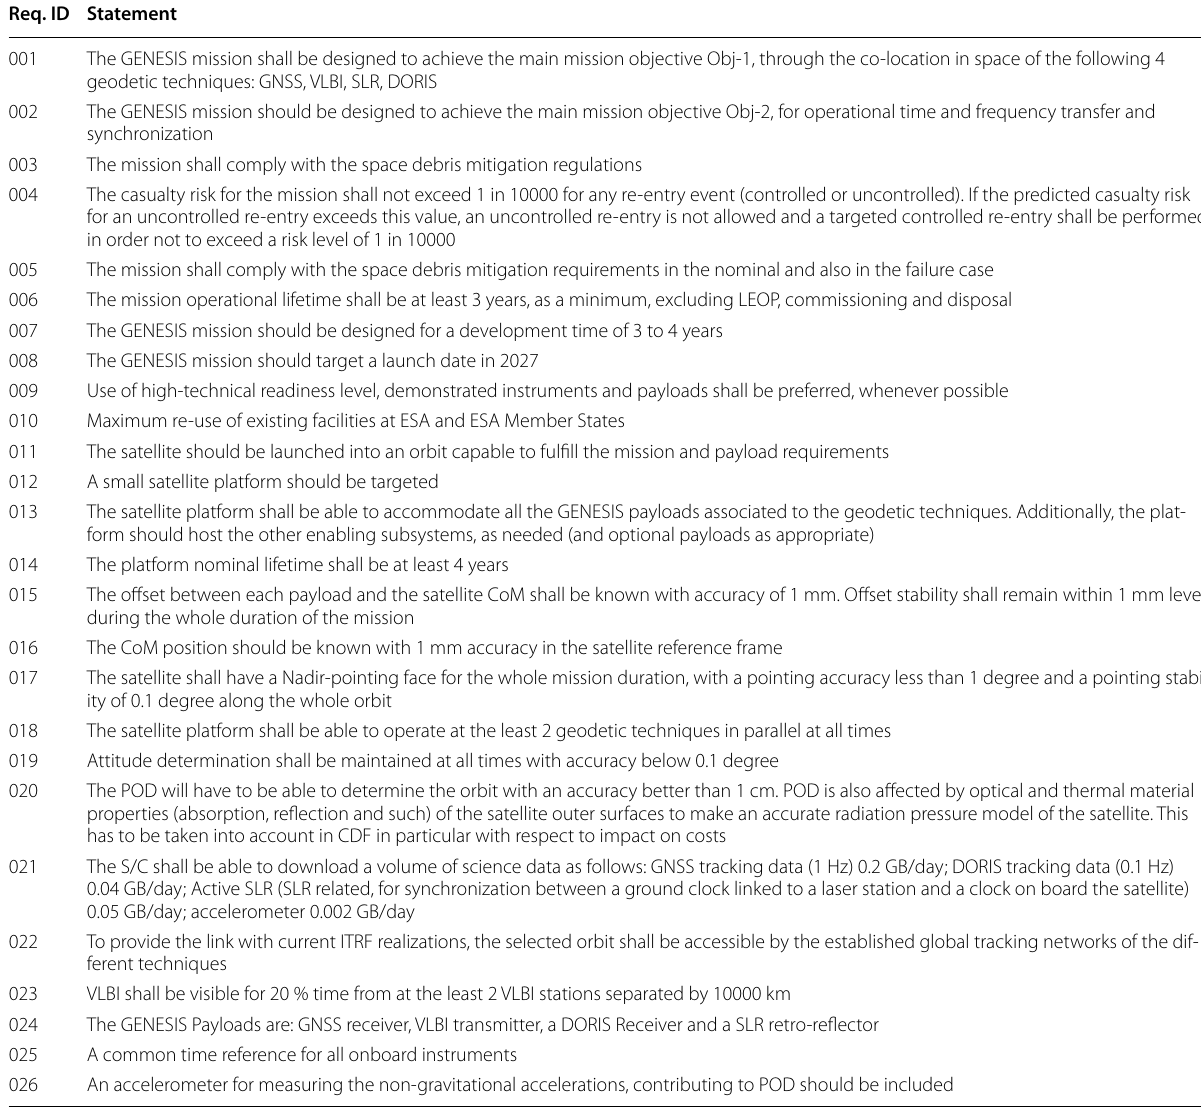
Table 3 First estimation of high‑level mission requirements for GENESIS Req. ID